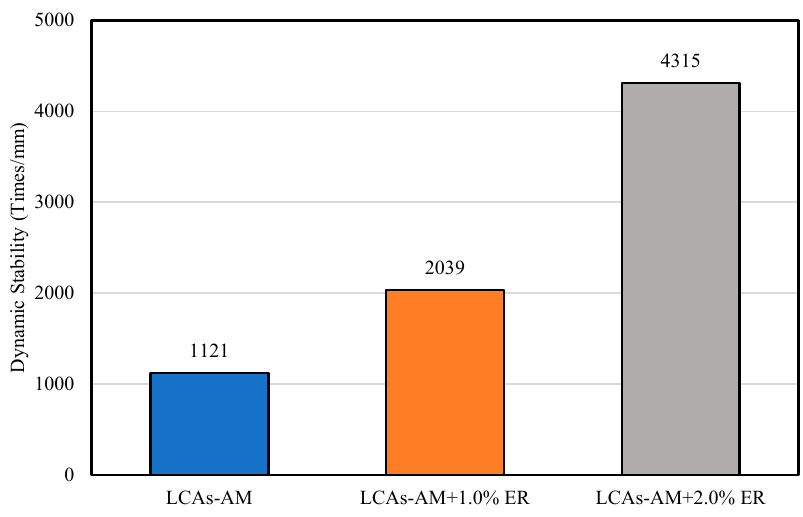
Figure 8. Dynamic stability of asphalt mixtures.